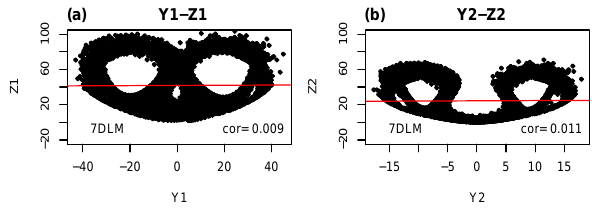
Figure 8. Scatter plots for Y 1 vs. Z 1 (a) and Y 2 vs. Z 2 (b) from the 7DLM with r =